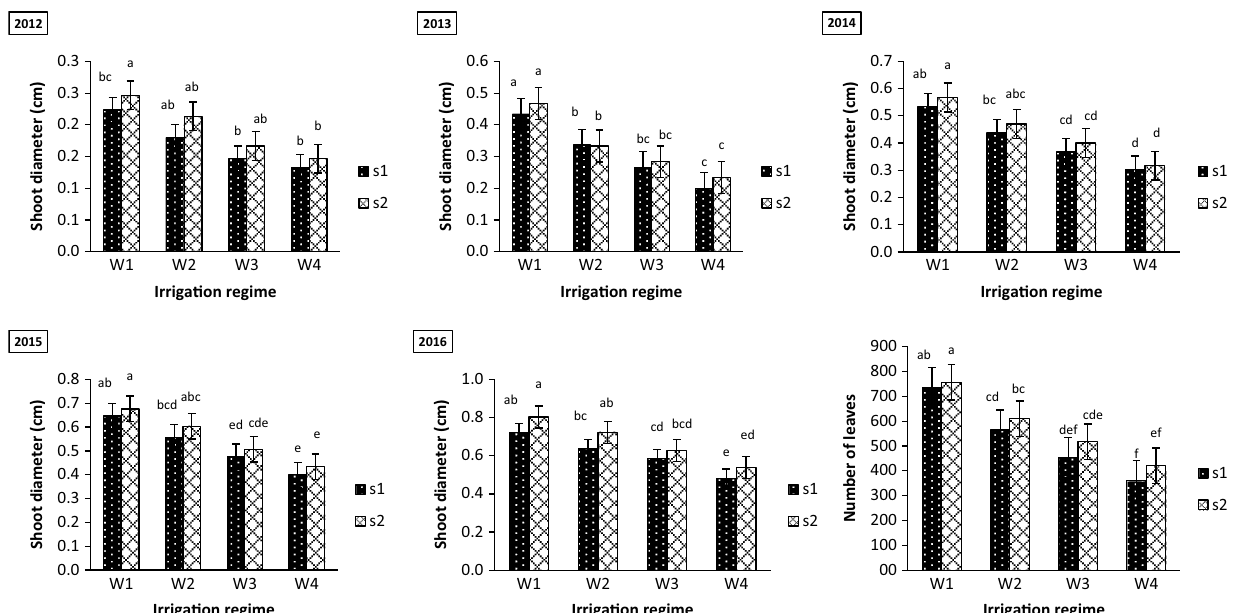
Fig. 5 Interactive effect of volcanic tuff and irrigation regime on shoot diameter and number of leaves for olive tree through the 5 years